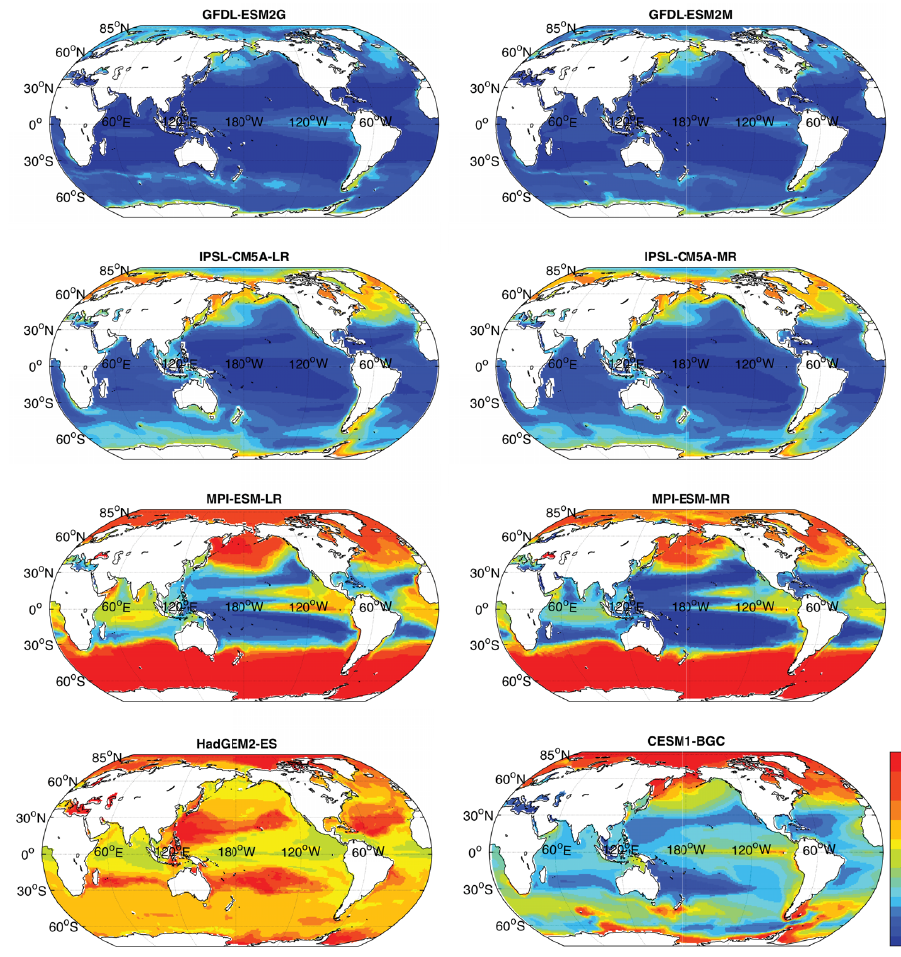
Figure 8. The fraction of total NPP by diatoms for the 1990s is shown for each model (data for NorESM not